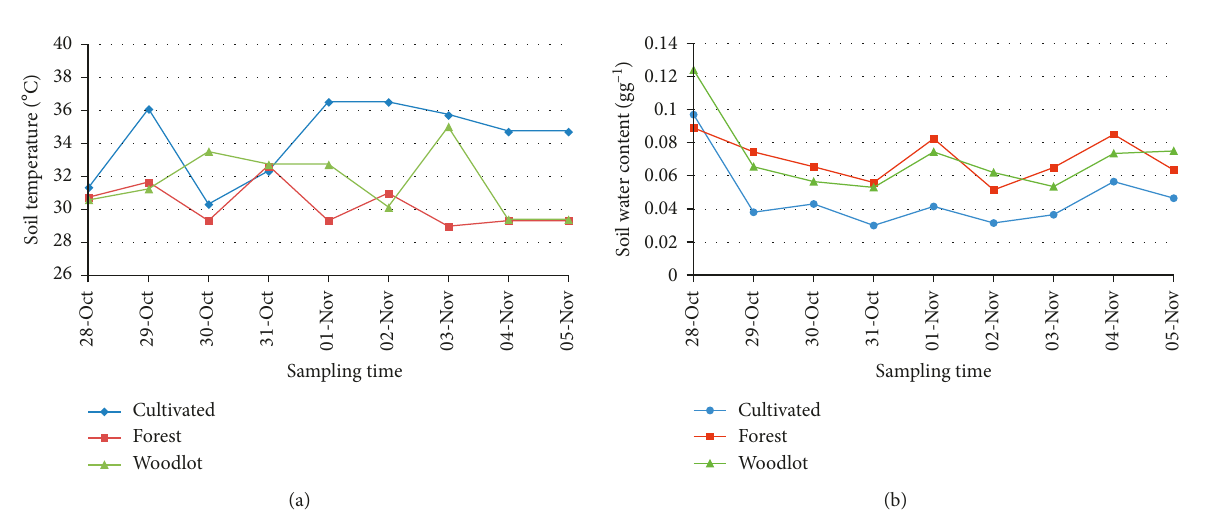
Figure 3: Variation of soil temperature (a) and soil moisture content (b) from different land-use systems at Legon